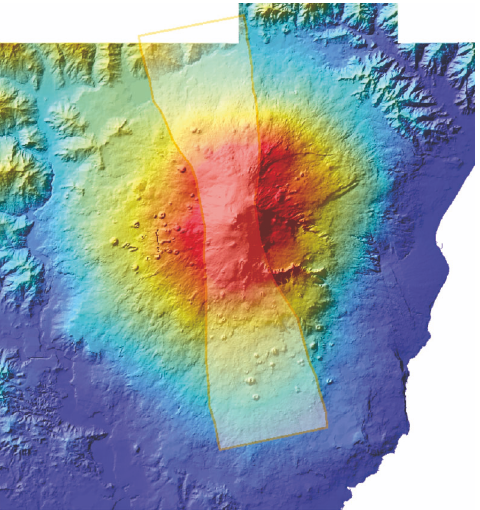
Fig. 5. Effective recorded surface according to dif- ferent pixel-sizes due to topographic variations.